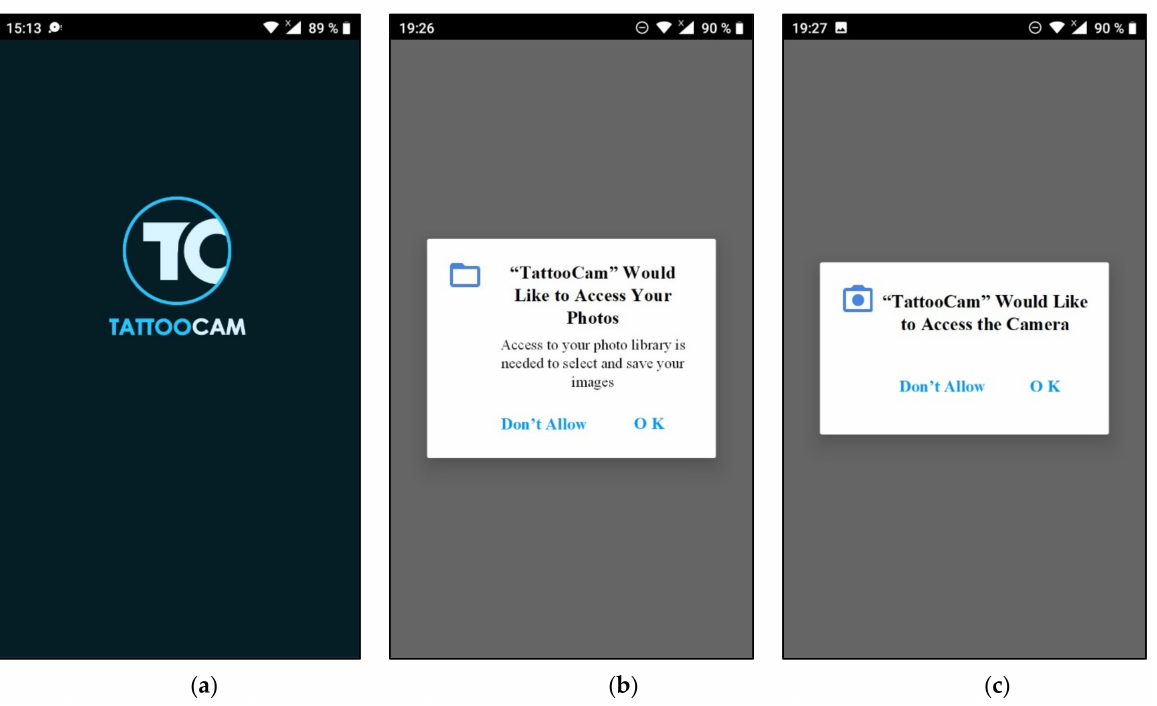
Figure 7. TattooCam application: ( a ) start the application; ( b ) access authorization to use the images of the device; ( c ) access authorization to use the camera of the device. Table 1. Hardware specifications of the computer used for developing the application.